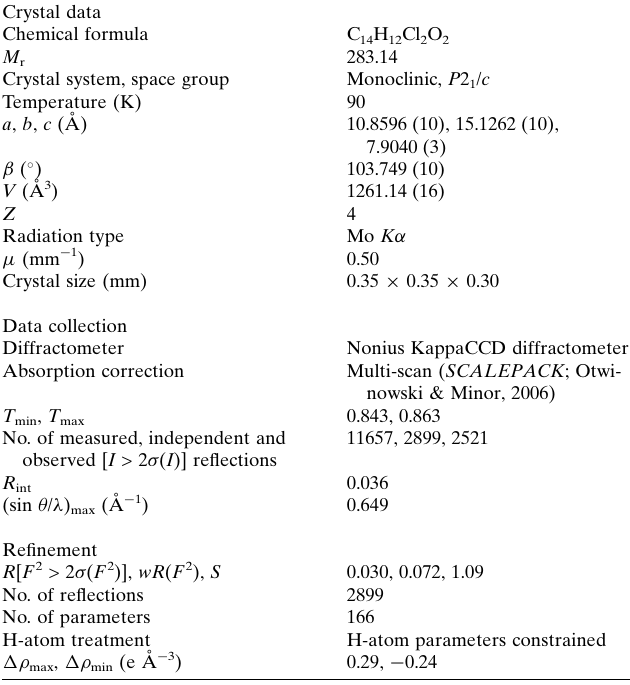
Crystal data Chemical formula